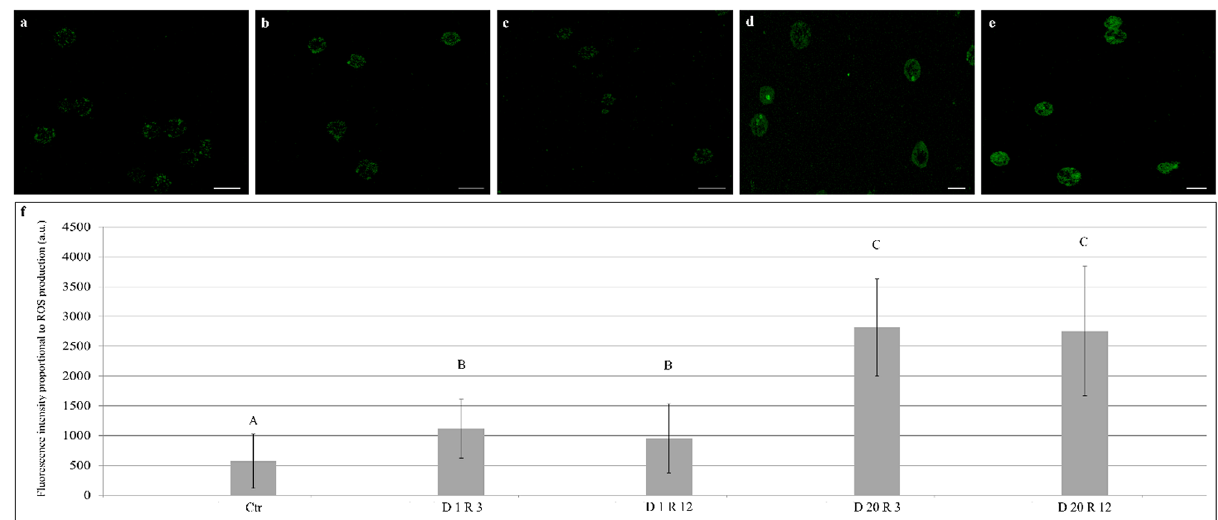
Figure 2. Intensity of fluorescence signal emitted by storage cells of the tardigrade Paramacrobiotus spatialis as a marker of ROS production, detected 3 h and 12 h after the rehydration process (R) in animals kept in a desiccated state (D) for 1 day and 20 days, using the fluorescent probe 2,7-dichlorodihydrofluorescein diacetate (DCFH 2 -DA). ( a ) Hydrated animals (control). ( b ) Animals kept in a desiccated state for 1 day (3 h after rehydration process). ( c ) Animals kept in a desiccated state for 1 day (12 h after rehydration process). ( d ) Animals kept in a desiccated state for 20 days (3 h after rehydration process). ( e ) Animals kept in a desiccated state for 20 days (12 h after rehydration process). ( a – e ) Scale bars = 10 µm. ( f ) Each column represents the mean value of the fluorescence intensity emitted by the storage cells for each experimental group. The total number (n) of measured cells is: Ctr, n = 138; D 1 R 3, n = 46; D 1 R 12, n = 78; D 20 R 3, n = 78; D 20 R 12, n = 36 (see (see Table S1). The bar on each column represents standard deviation. Different letters above each column indicate significant differences in the fluorescence signals among the different experimental conditions. a.u. = arbitrary unit. D 1 = animals kept in a desiccated state for 1 day, D 20 = animals kept in a desiccated state for 20 days, R 3 = 3 h after the rehydration process, R 12 = 12 h after the rehydration process, Ctr = control animals. The storage cells of desiccated animals always emitted an intense fluorescence signal, while those of control ones emitted a faint spotted fluorescence signal (Fig. 2). The intensity of the fluorescence signal emitted by the storage cells of desiccated animals was always significantly higher than the fluorescence intensity detected in cells of control animals (Fig. 2; Table 1; one-way ANOVA: n = 485; p < 0.001). Moreover, the intensity of the fluorescence signal was at its highest level in the coelomocytes of animals kept desiccated for 20 days, while the lowest signal was recorded in cells of tardigrades kept desiccated for 1 day (Fig. 2; Table cells in the body cavity of tardigrades which act as reservoirs and transporters of lipids and glycogen 49–52 . The